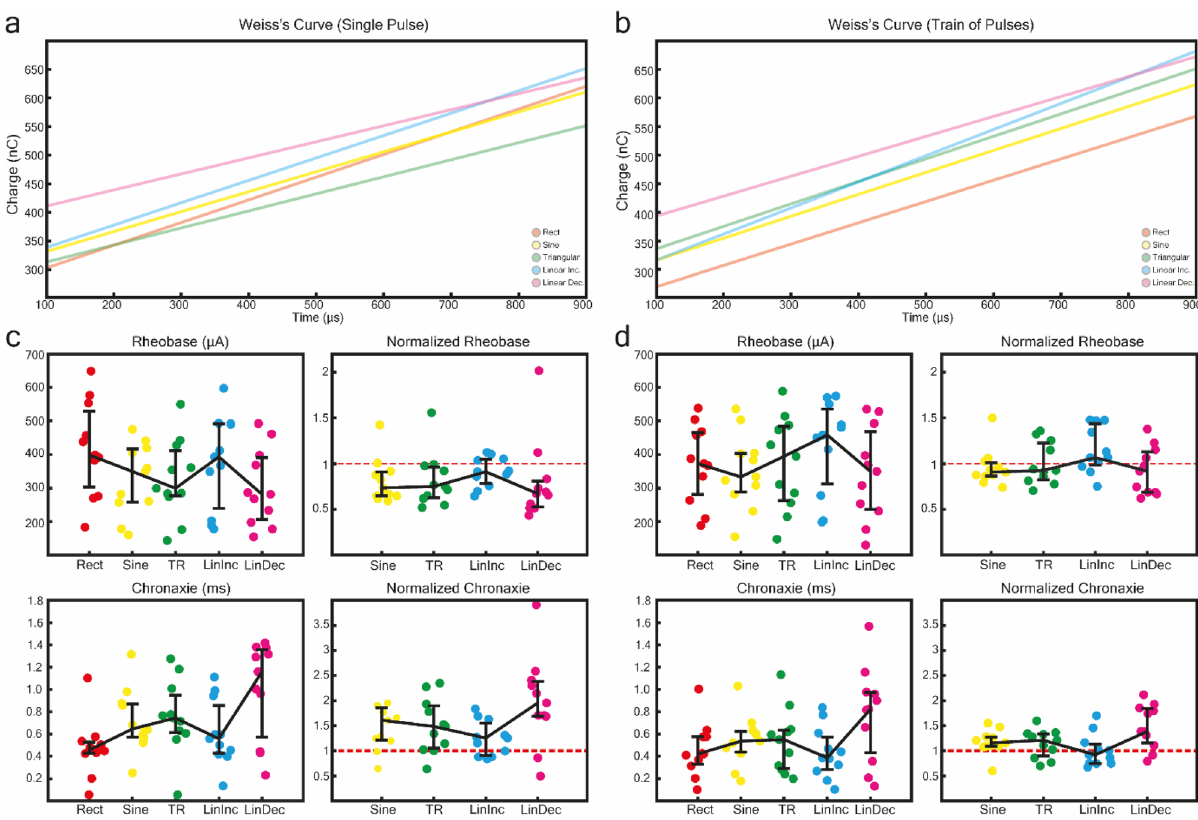
Figure 2. ( a ) Weiss’s curve fitting the data obtained from stimulation with single pulse. ( b ) Weiss’s curve fitting the data obtained from stimulation with train of 15 pulses at 30 Hz. ( c ) Rheobase and Chronaxie estimates from fitting Weiss’s curve to stimulation data with single pulse, displayed as both raw estimates (left two plots) and normalized with respect to Rect (right two plots). ( d ) Rheobase and Chronaxie estimates from fitting Weiss’s curve to stimulation data with train of 15 pulses at 30 Hz pulse, displayed as both raw estimates (left two plots) and normalized with respect to Rect (right two plots). Single Pulse Train of Shape